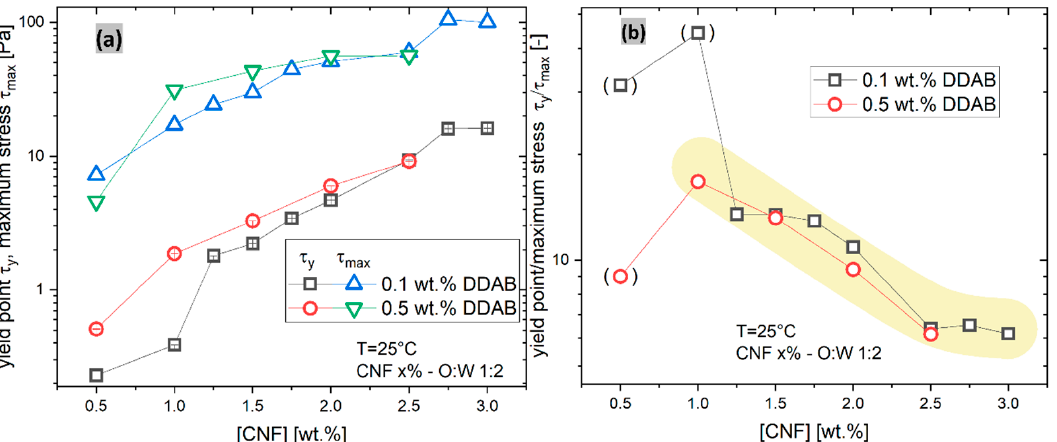
Figure 9. ( a ) Dependence of yield stress values τ y on the CNF or DDAB composition. The error bars are the uncertainties of the fit. ( b ) Relation between viscosity at 10 s − 1 and emulsion constituents. When comparing the data of the samples with 0.5 wt.% DDAB (Figure 8b,d) with those with 0.1 wt.% DDAB (Figure 8a,c), the samples with 0.5 wt.% DDAB (except for the CNF0.5%-DDAB0.5%-O:W 1:2 sample, which is very similar to